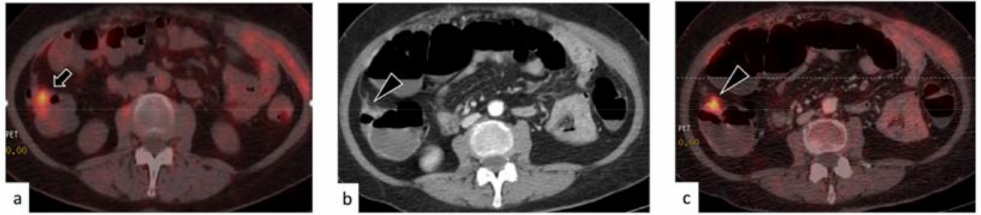
Figure 3. Example of clarification of a paracolic finding with positron emission tomography/contrast enhanced X-ray computed tomography (PET/ceCT). The PET/low dose (ld)CT ( a ) displayed unspecific-looking intestinal uptake, without a definite CT correlate (arrow). The PET/ceCT ( b , c ) identified a paracolic nodule, which was suggestive of the presence of active disease (arrowheads). This nodule disappeared after chemotherapy and therefore was confirmed as a true positive